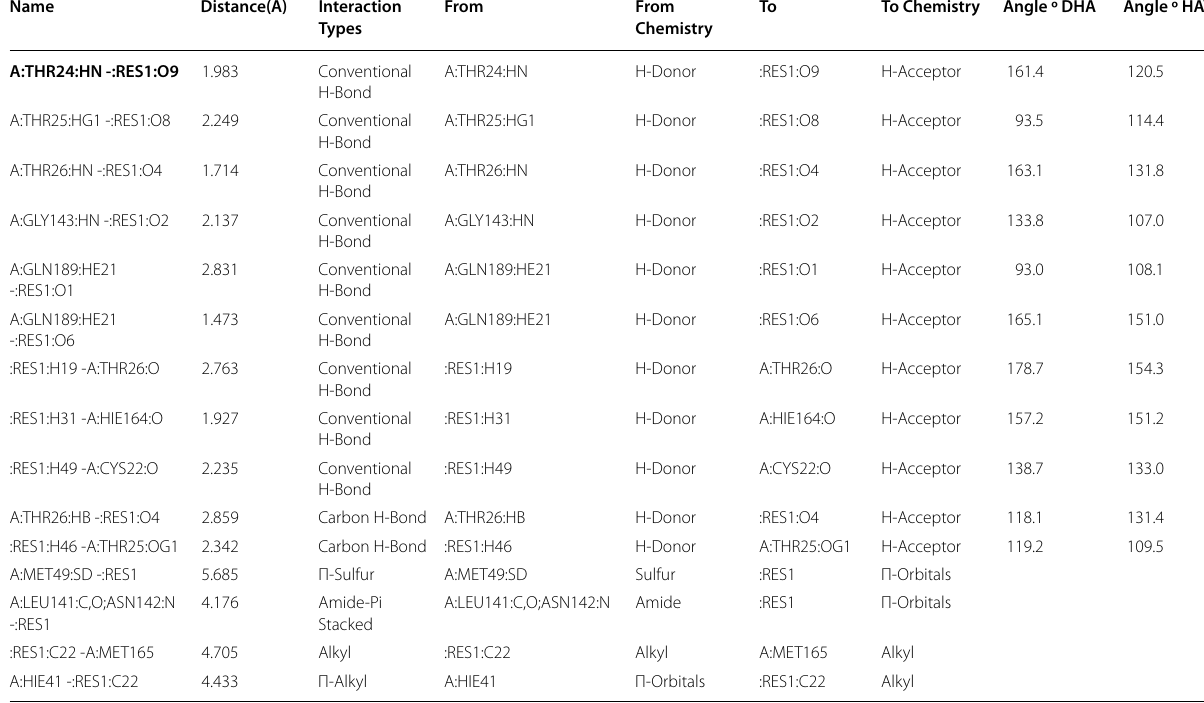
Table 3 Interaction types with surrounding amino acids of SARS COV 19 Main Protease (PDB ID: 6XBH) with inhibitor Index no. 441 Name